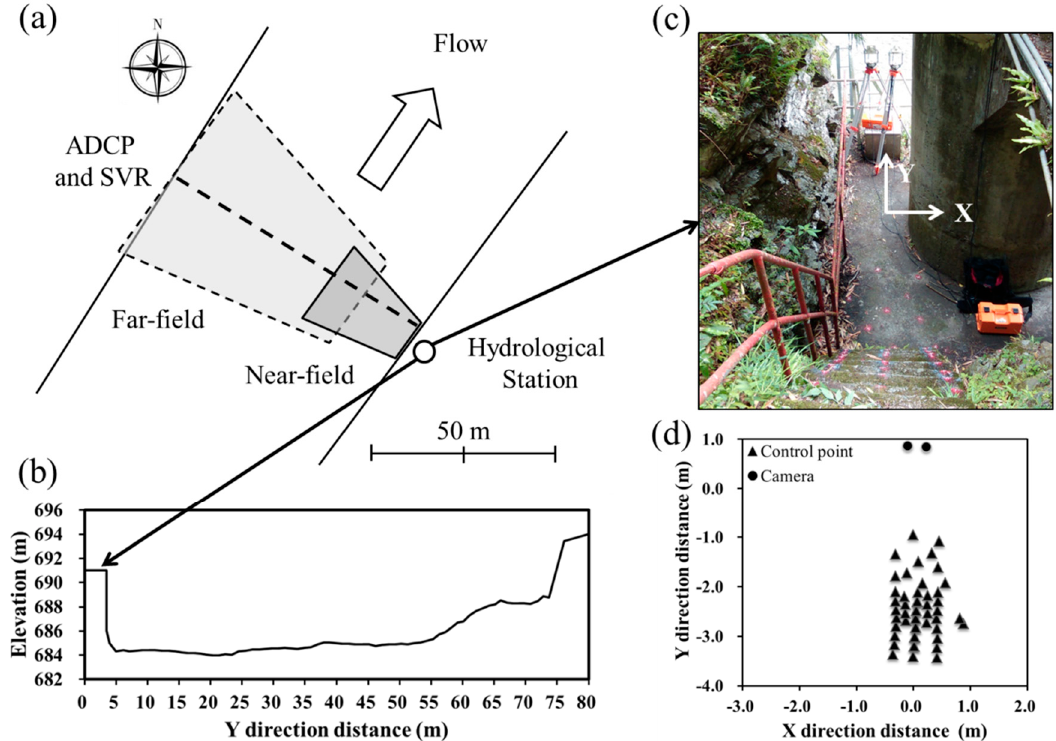
Figure 3. ( a ) Illustration for the near-field and far-field camera view angles at Yufeng gauging station. Note that the acoustic Doppler current profile (ADCP) and surface velocity radar (SVR) data acquisition campaign along the river is also shown in the figure, ( b ) cross section of the river ( from right bank to left bank ), ( c ) picture of the control points, and ( d ) measured locations of control points in a horizontal plane during image calibration.